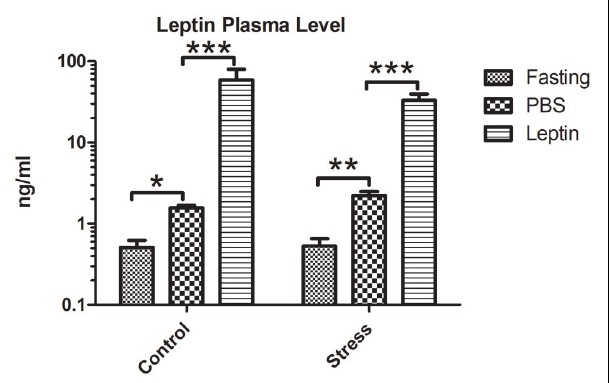
FIGURE 3 | Leptin plasma level in the various experimental groups. Vertical bars represent the means + SEM; N = 5. Asterisks indicate significant differences between fasting, PBS and leptin treated groups. * P < 0.05; ** P < 0.01; *** P <